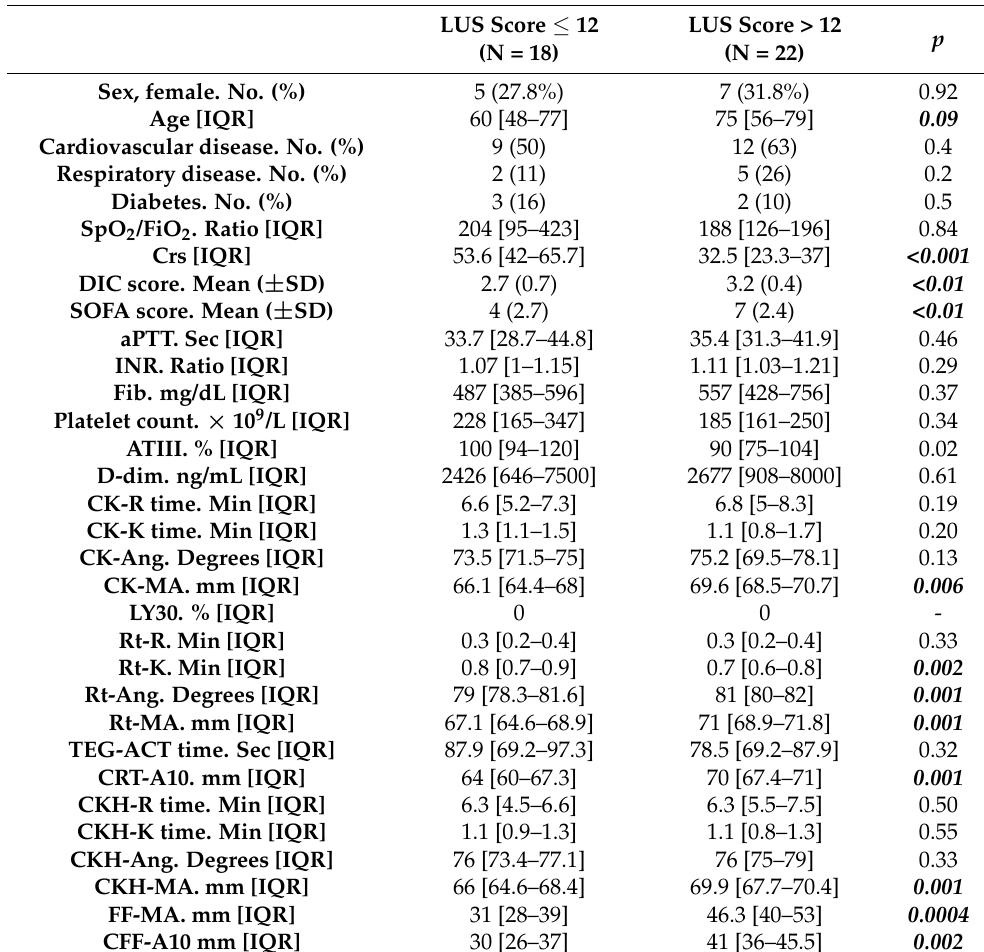
Table 1. Demographic, Clinical and Laboratory Characteristics. Data are expressed as: median [interquartile range, IQR], frequencies (%). DIC and SOFA scores are expressed as mean ± standard deviation ( ±